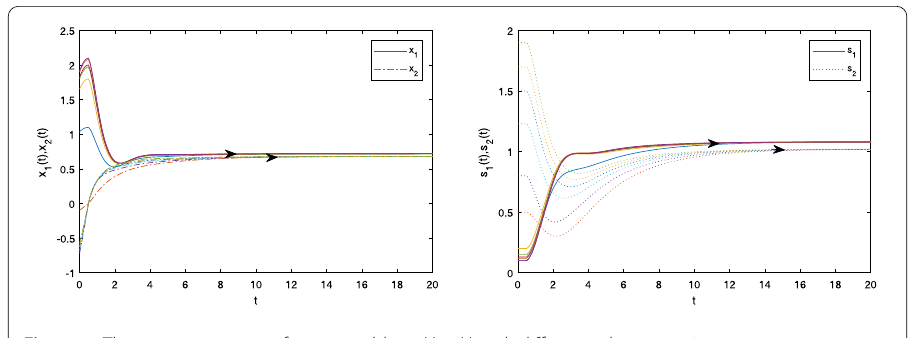
Figure 1 The state trajectories of state variables x i ( t ), s i ( t ) with different values, i =